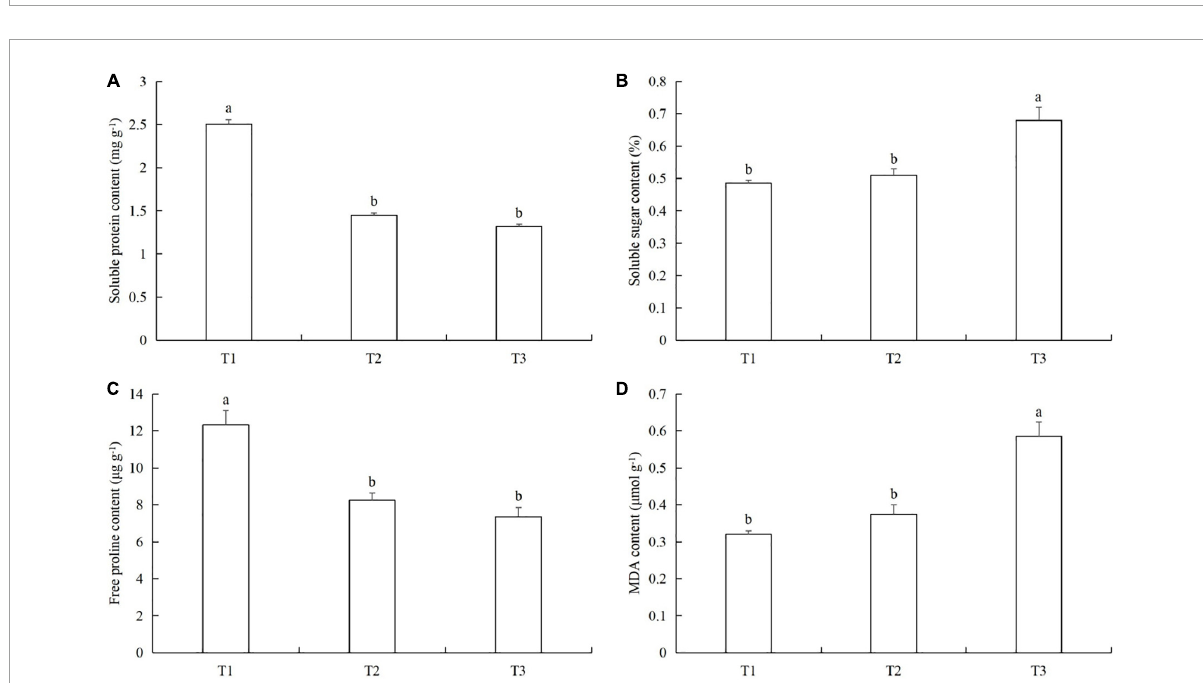
FIGURE8 The effects of timing and order of powdery mildew infection and aphid colonization on the contents of (A) soluble proteins, (B) soluble sugars, (C) free proline, and (D) malondialdehyde (MDA) in cucumber leaves. T1, Powdery mildew followed by aphids. T2, Simultaneous powdery mildew infection and aphid colonization. T3, Aphid colonization followed by powdery mildew infection. The mean value ± p < 0.05 error bar data were presented in the figure and different alphabetical letters indicate the significant differences between the different time